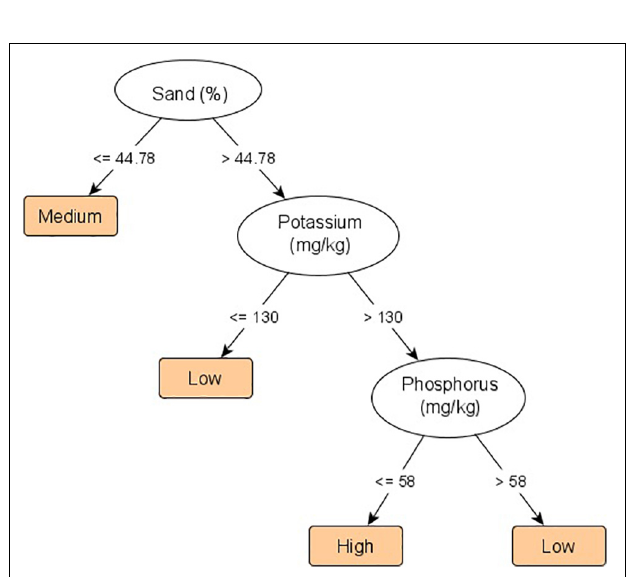
FIGURE 3 | Classification tree for predicting stabilization factor (S). Low represent values ( ≤ 0.15), medium values (0.15–0.29), and high values ( >